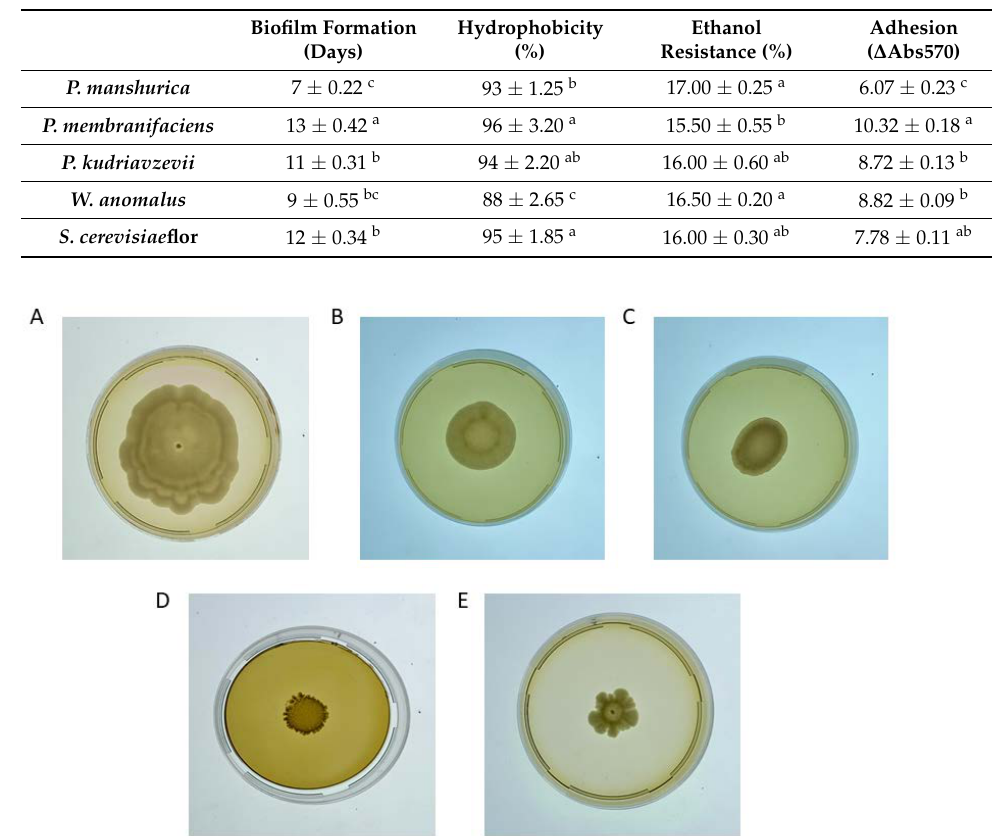
Figure 2. MAT morphology on YPD with low-density agar (0.3%, w/w ): ( A ) P. membranifaciens ; ( B ) P. kudriavzevii ; ( C ) P. manshurica ; ( D ) W. anomalus ; ( E ) S. cerevisiae